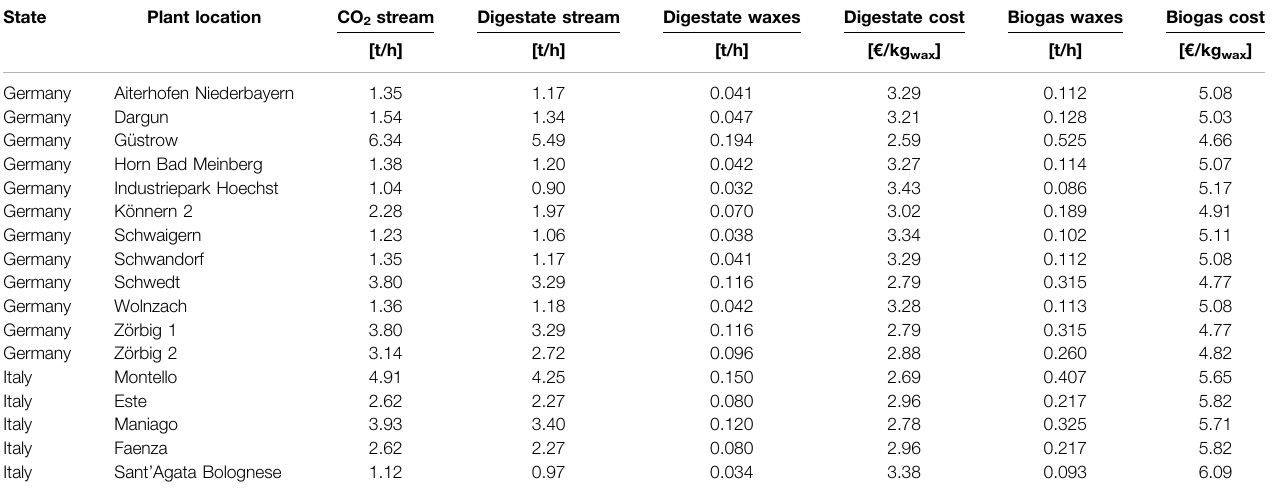
TABLE 5 | Preferential plant location in Germany and Italy, with production and cost of waxes from digestate and carbon